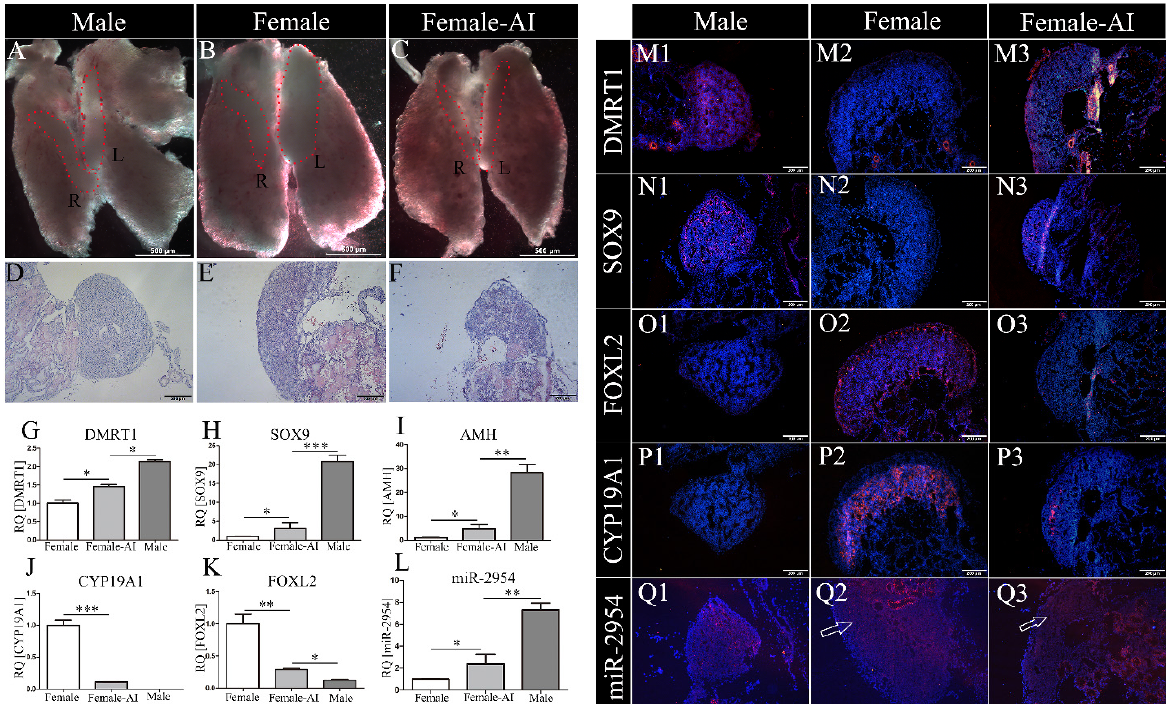
Figure 3. The morphology and gene expression in gonads at E10 chicken after AI treatment. ( A – C ) Gonads on top of the mesonephros in male, female, and AI-treated female chicken, respectively. ( R ) indicates right gonad, ( L ) indicates left gonad. ( D – F ) HE staining of gonads in male, female, and AI-treated female, respectively. In all HE staining images, the left gonad was selected. Scale bar as is shown in pictures, thickness = 6 μ m. ( G – L ) Q-PCR expression of DMRT1 , SOX9 , AMH , CYP19A1 , FOXL2, and miR-2954, respectively. Error bars show standard error of the mean (SEM) from at least three biological replicates in each group. Asterisks indicate statistical significance, * p < 0.05, ** p < 0.01, *** p < 0.0001. ( M1 – M3,N1 – N3,O1 – O3,P1 – P3 ) Immunofluorescence results of DMRT1, SOX9, FOXL2, and CYP19A1 in control and AI-treated gonads. ( Q1 – Q3 ) In situ hybridization of miR-2954 in male, female, and AI-treated female. Blue fluorescence shows DAPI, which marks the nucleus; red fluorescence indicates expression of sex markers or miR-2954. Scale bar = 200 μ m, thickness = 10 μ m.